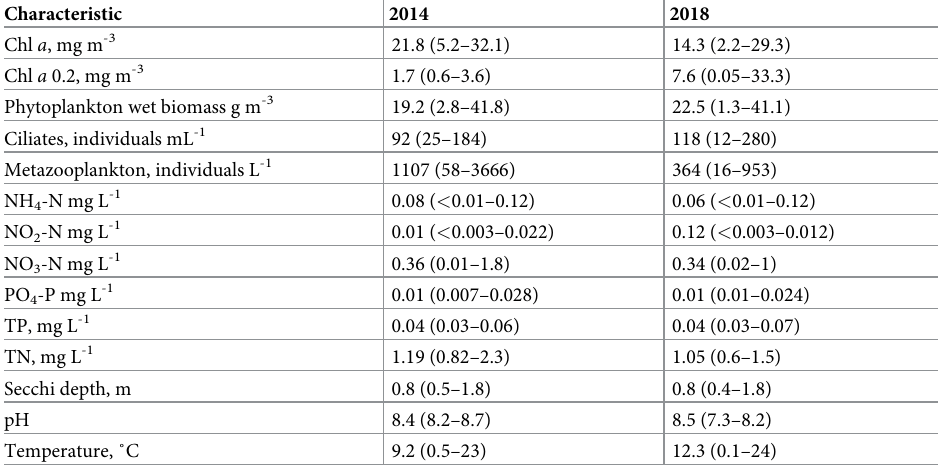
Table 1. Mean and range of chemical, physical and biological parameters measured in Lake V õ rtsja¨rv in years 2014 and 2018. Characteristic